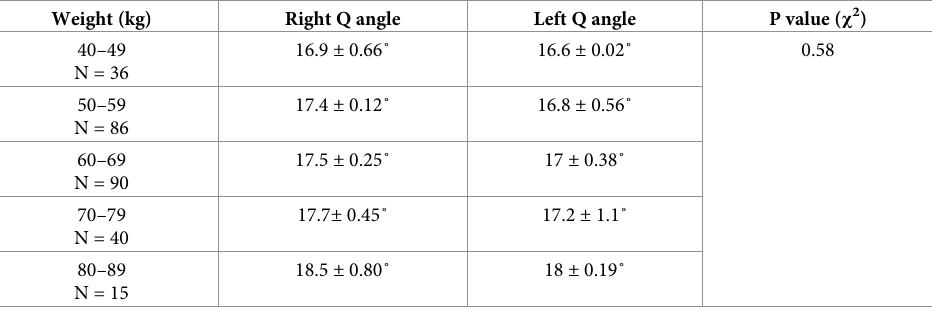
Table 2. Measurements of the Q angle with respect to weight in the adult